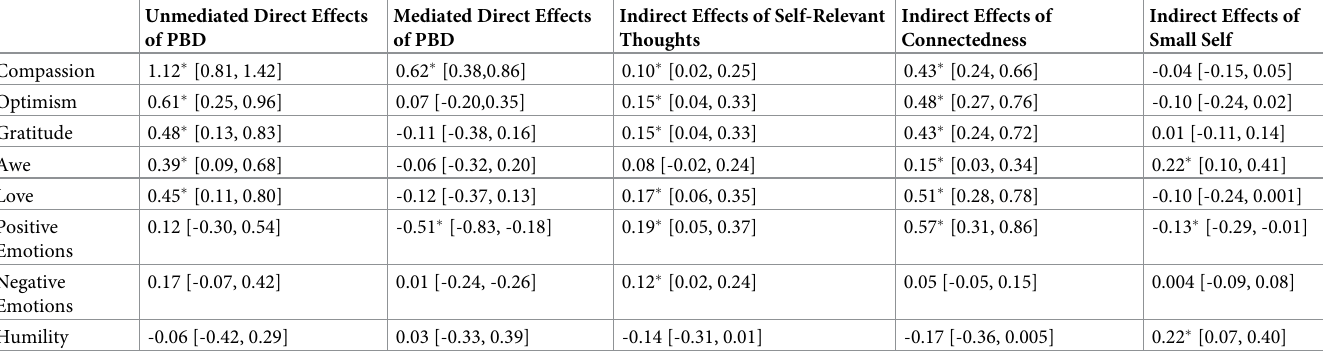
Table 5. Indirect effects of self-relevant thoughts, connectedness, and small self on emotion outcomes (Study 2).